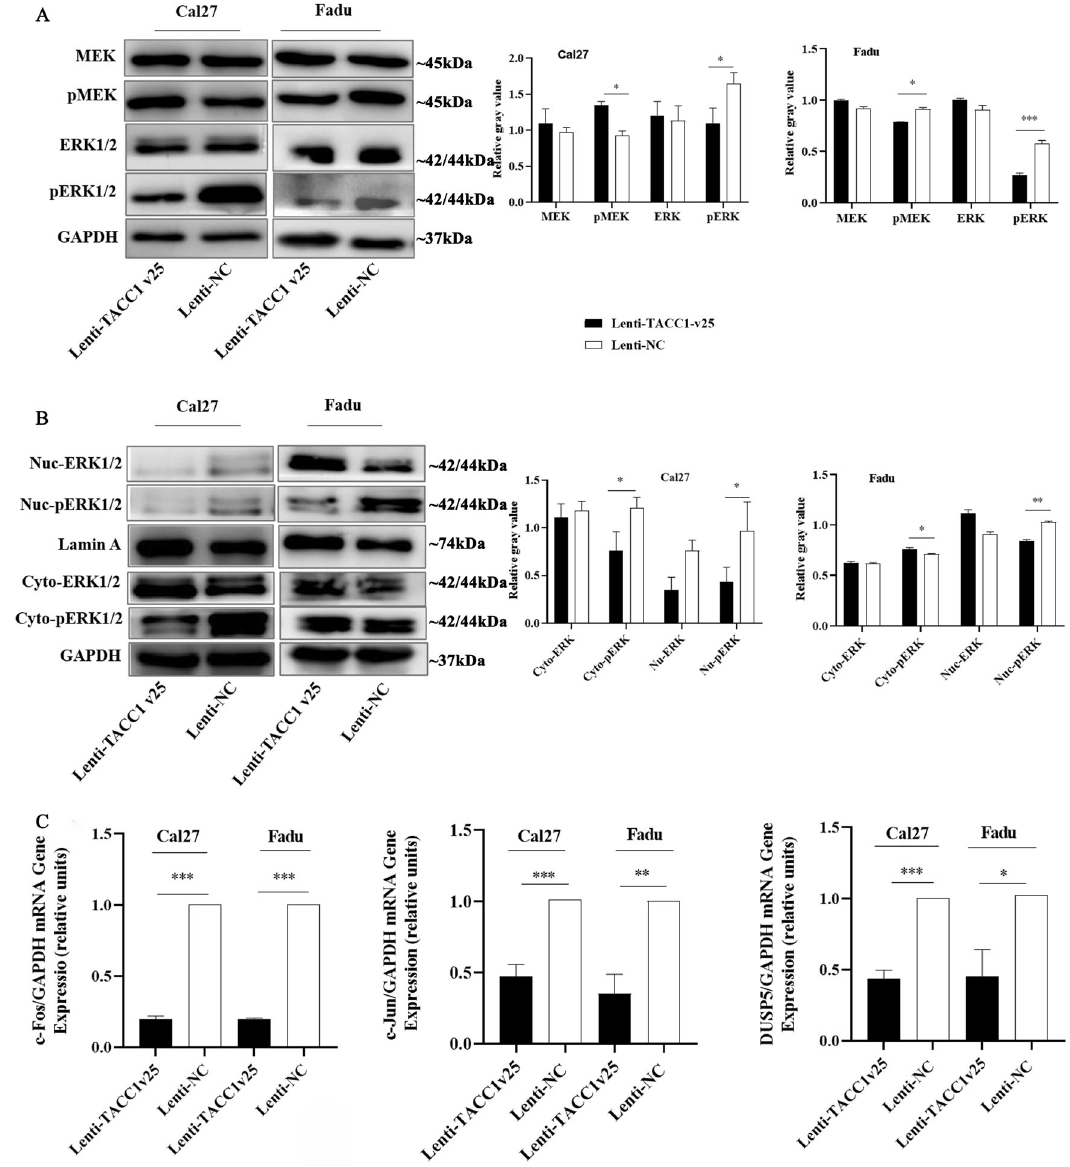
Fig. 4 TACC1v25 reduces the phosphorylation of ERK in HNSCC. A Western blot analysis of total phosphorylation levels of the ERK pathway. Total expression of ERK was unchanged but expression of pERK was decreased in established Lenti-TACC1v25-Cal27/-Fadu cells. B Western blot analysis of nucleus and cytoplasmic phosphorylation level of ERK. The expression of pERK in nucleus is decreased in Lenti-TACC1v25- Cal27/-Fadu cells. The expression of cytoplasmic pERK is greatly decreased in Lenti-TACC1v25-Cal27 cells; however, it is slightly higher in Lenti- TACC1v25-Fadu cells. C Expression of downstream genes of the ERK pathway, c-Fos and c-Jun, are signi fi cantly downregulated in Lenti- TACC1v25-Cal27/-Fadu cells, and the ERK-speci fi c inducible ribozyme, DUSP5, is also decreased. Cyto., Cytoplasm; Nuc., Nucleus. * P < 0.05, ** P < 0.01, *** P <